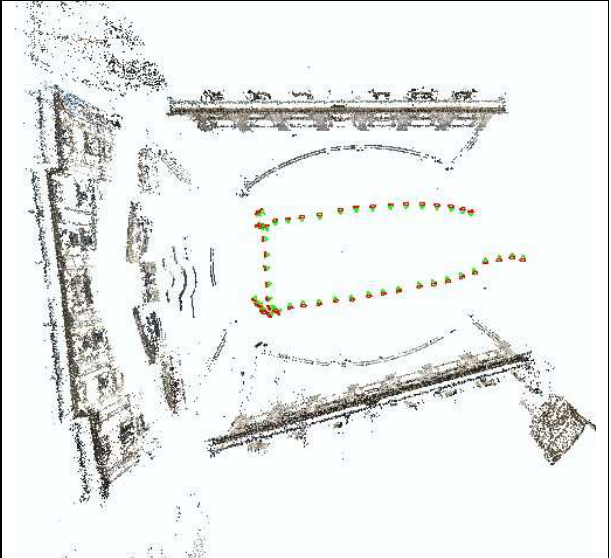
Figure 7bis Result campidoglio